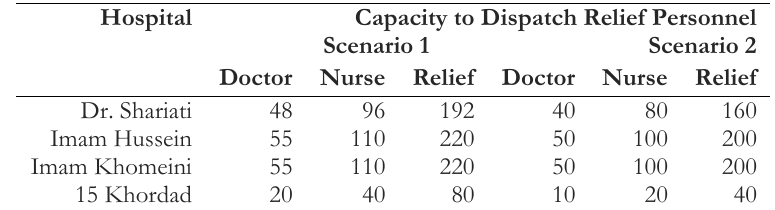
Table 8. Capacity of dispatching relief personnel in each hospital.